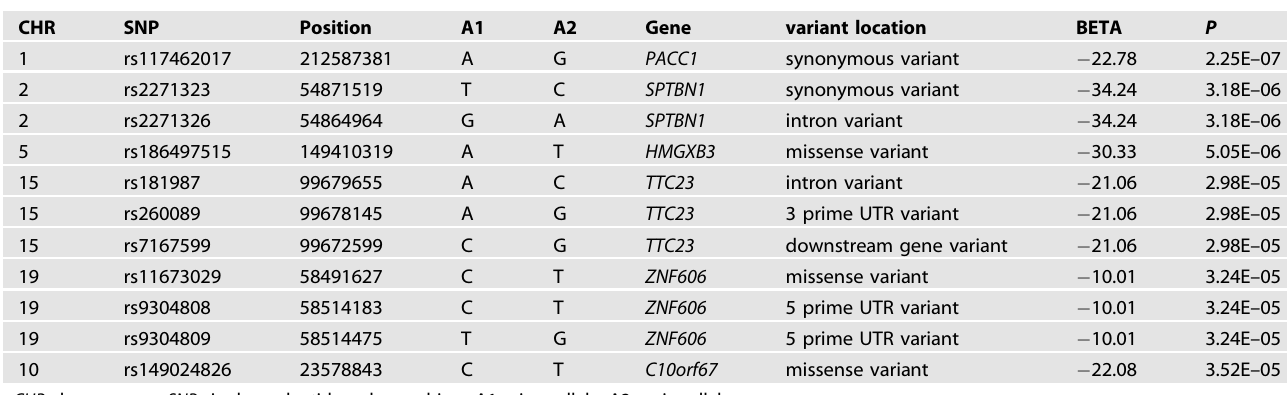
Fig. 2 Manhattan plots of P values against their respective chromosomal positions for whole exome sequencing study. The bule line corresponds to the P < 1 × 10 − 5 , while the red line represents the genome-wide signi fi cance level ( P < 5 × 10 − 8 ). Table 2. Genomic regions of common variants in the whole exome sequencing analyses.